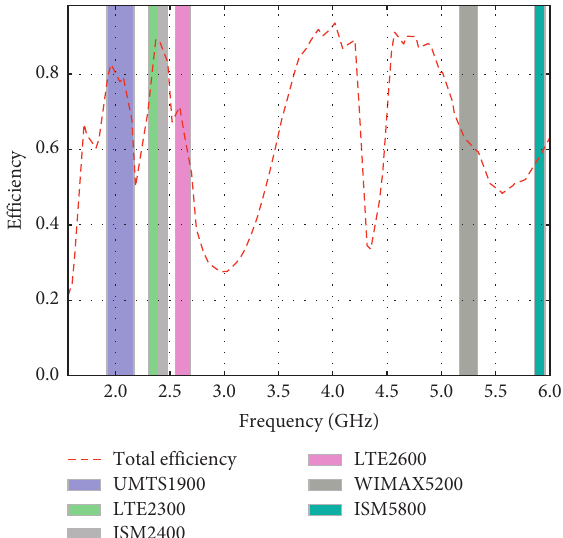
Figure 11: Variation of the total efficiency over frequencies.